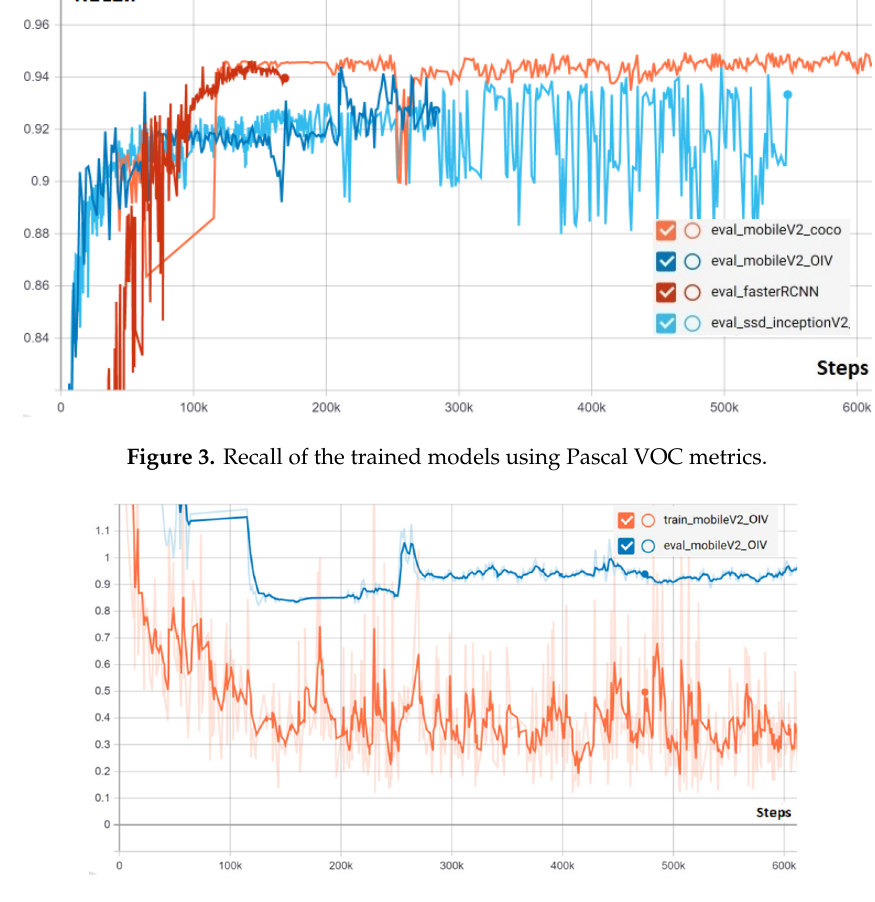
Figure 4. Classification loss training vs. validation MobileNetV2 pre ‐ trained on OID.